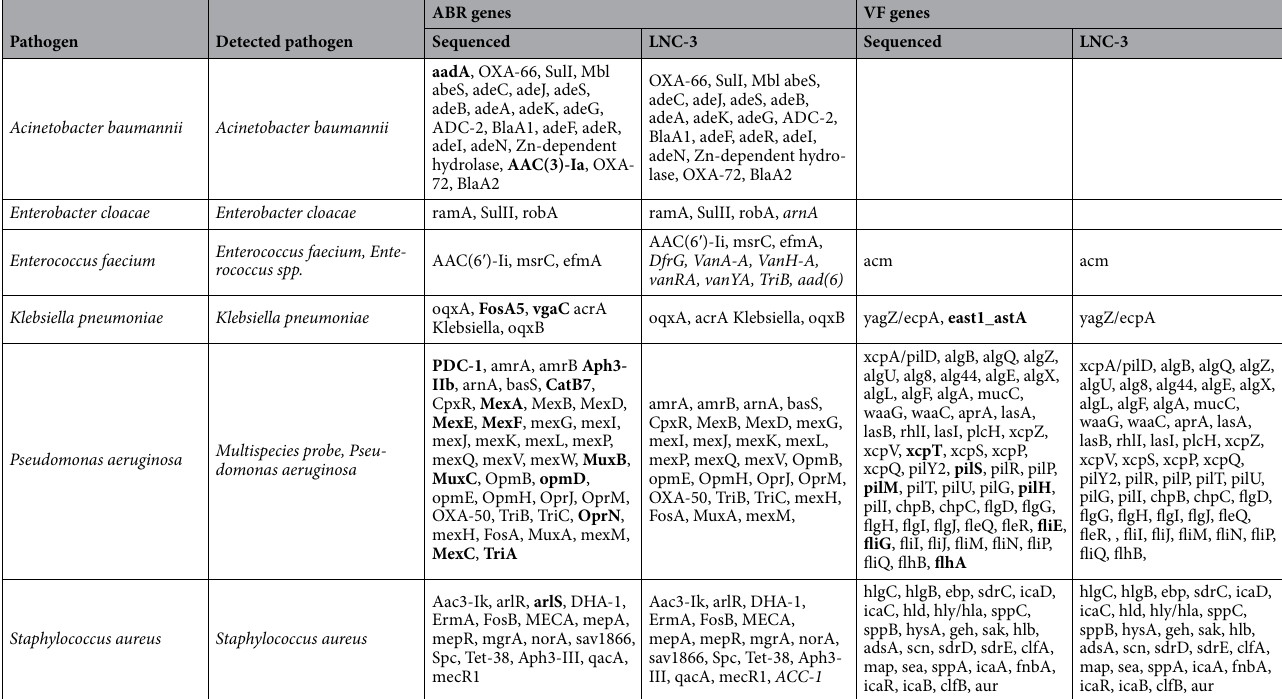
Table 2. Characterisation of bacterial isolates using LNC-3 probes targeting ABR genes and VF genes. LNC-3- derived signals are compared with whole genome sequencing data. Genes found in sequence data but without LNC-3 response are indicated in bold letters, LNC-3 responses that were not found via sequencing are written in